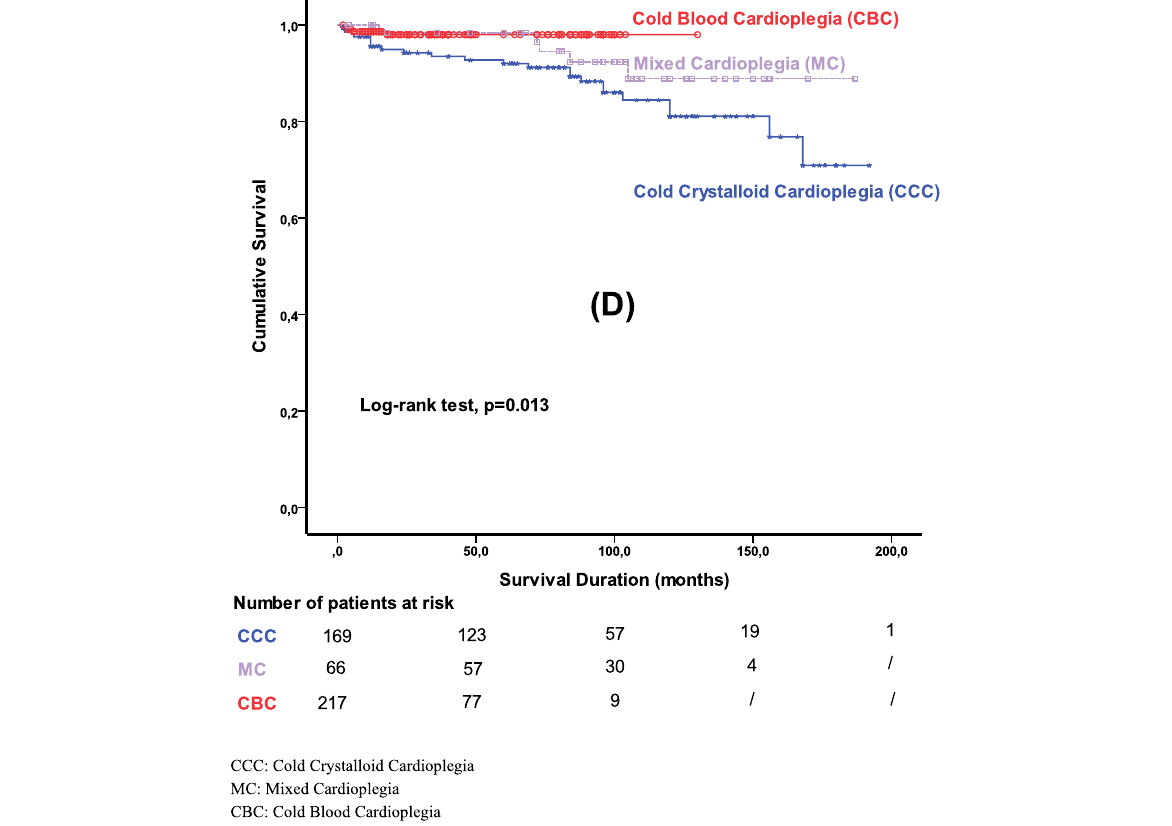
Fig. 4 Kaplan-Meier survival curve (D) for the whole cohort with comparison between cardioplegia protocols: cold blood cardioplegia ( n = 242, 45.7%), mixed cardioplegia ( n = 78, 14.7%), and cold crystalloid cardioplegia ( n = 209, 39.5%). CCC: cold crystalloid cardioplegia, MC: